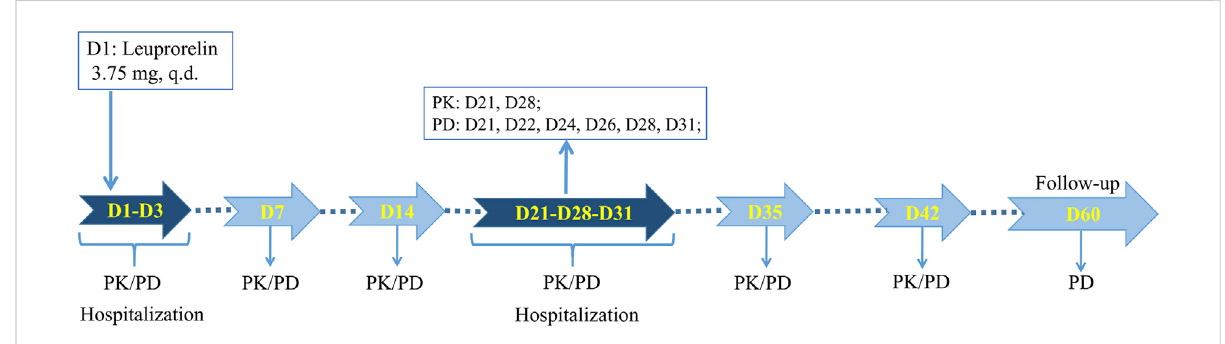
FIGURE 1 Flow chart of clinical trial